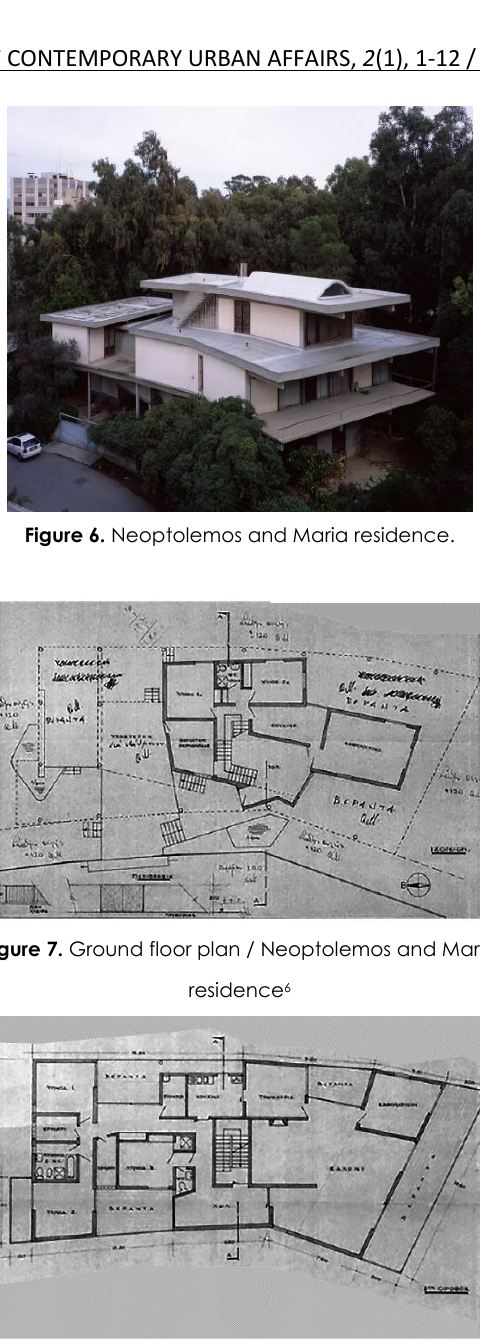
Figure 8 . First-floor plan.